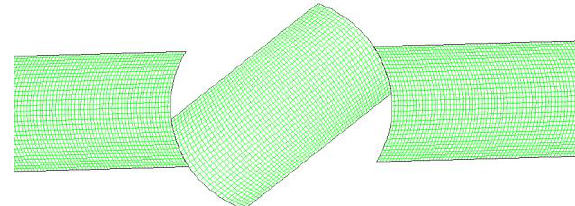
Figure 3. Sketch of the grid.